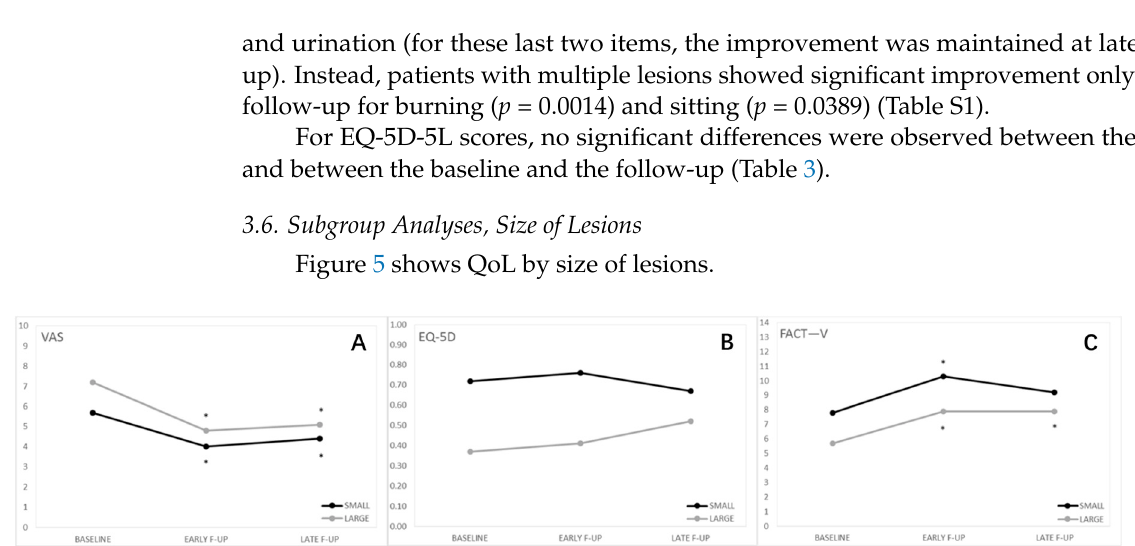
Figure 5. Quality of life by size of lesion(s). ( A ) Visual analog pain scale (VAS); ( B ) Functional Assessment of Cancer Therapy—Vulva cancer (FACT-V); ( C ) EuroQol 5-Dimension 5-Level (EQ-5D-5L). * The largest lesions are those that result in the worst QoL.